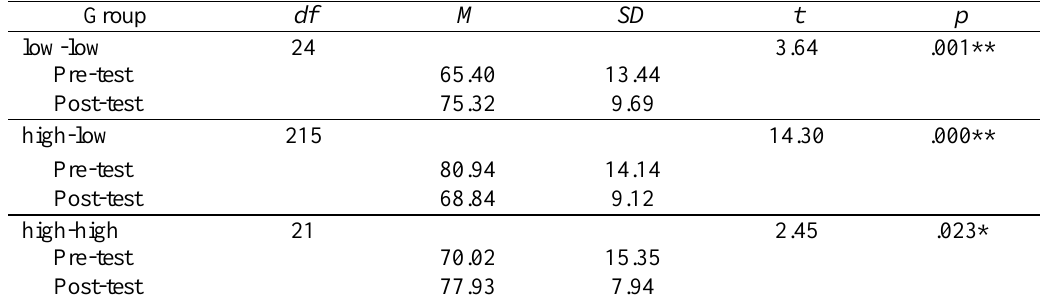
Table 2 Performance differences before and after engaging in one-to-one environment Group df M low-low